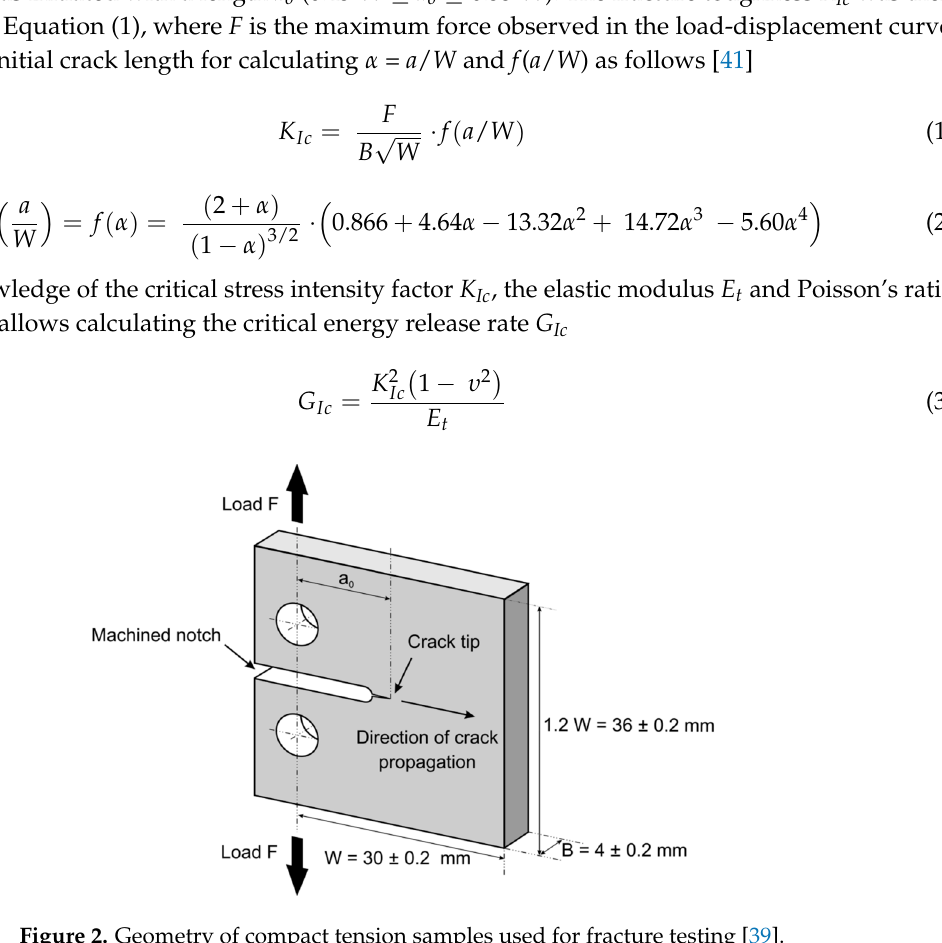
Figure 2. Geometry of compact tension samples used for fracture testing [39].